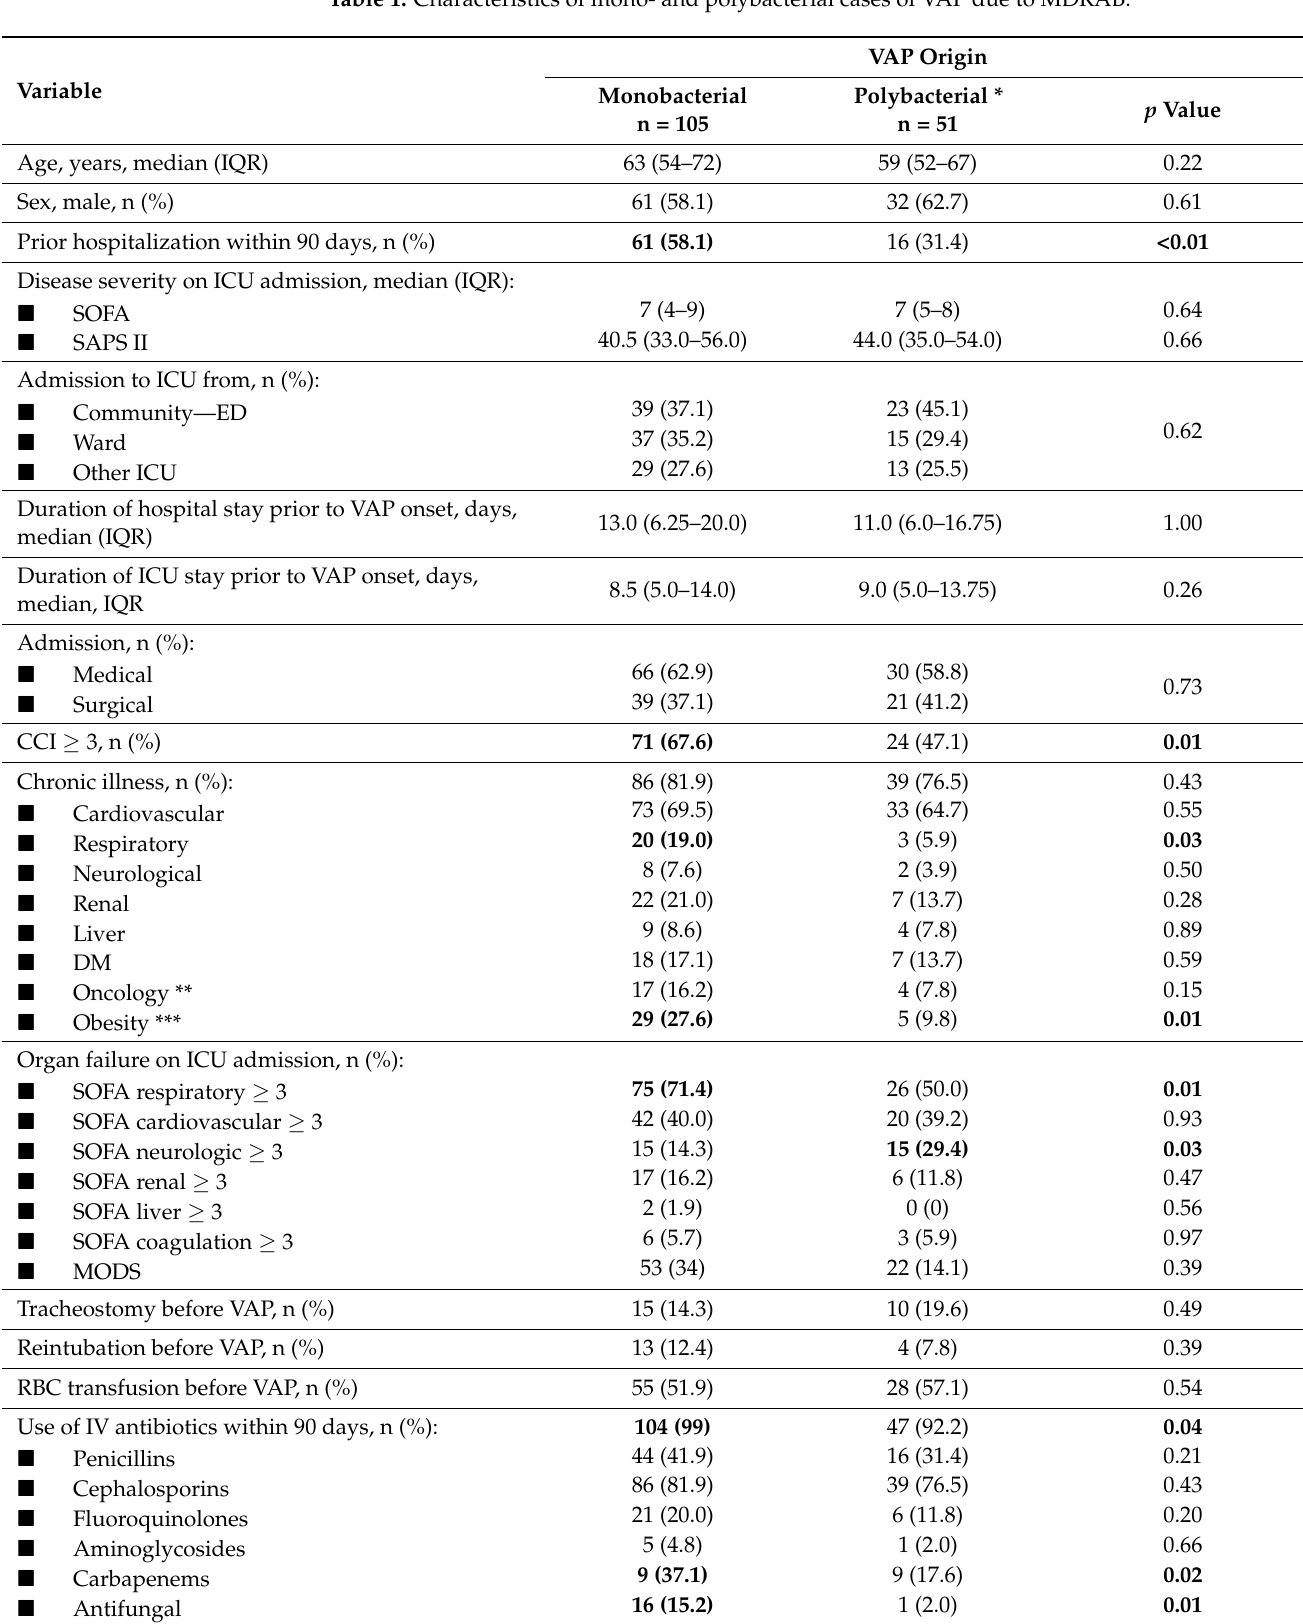
Table 1. Characteristics of mono- and polybacterial cases of VAP due to